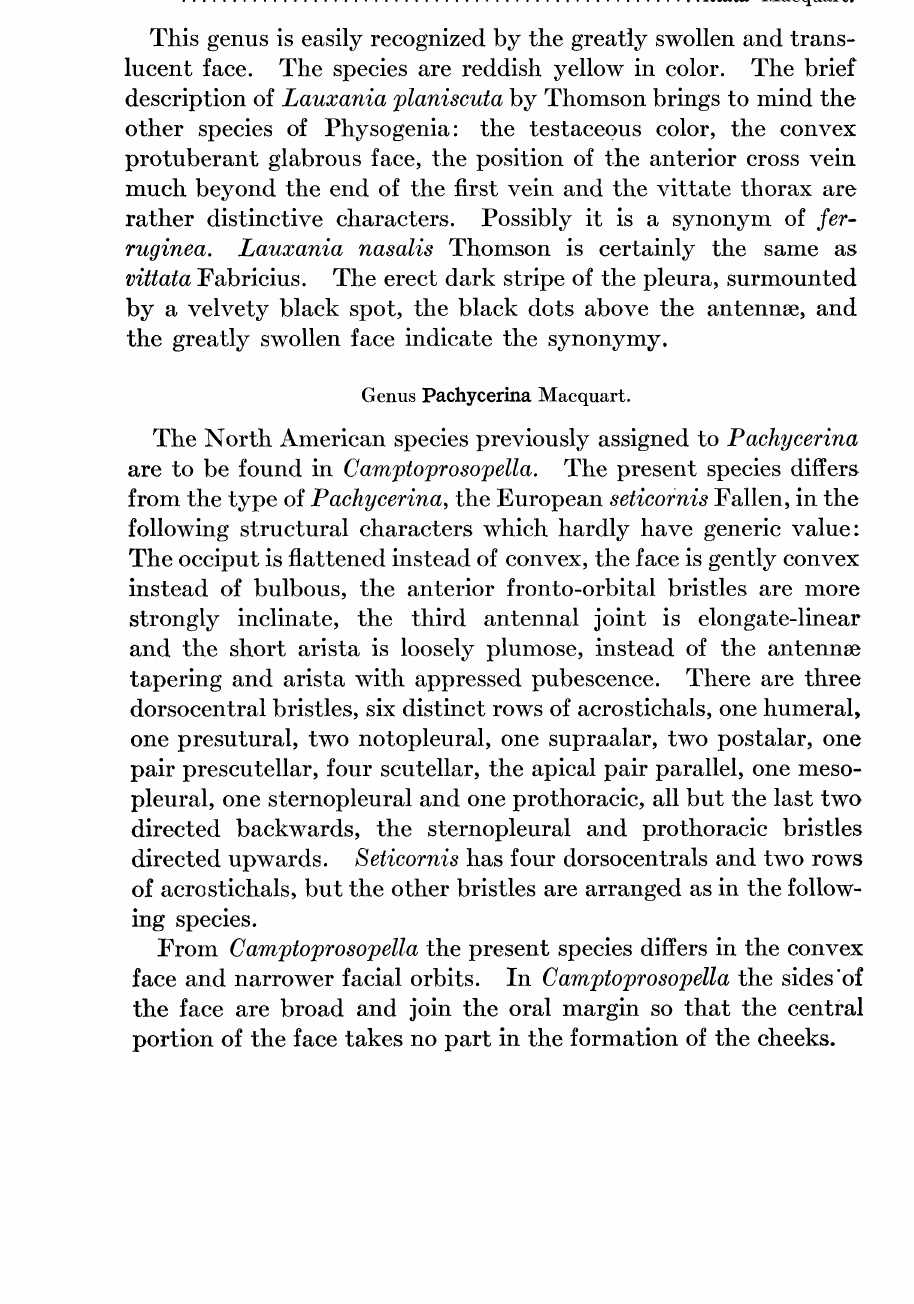
Psyche [April Face translucent yellow; thorax weakly bivittate. S. Am., Mex.* (urina Giglio-Tos) ferruginea Schiner. Face trimaculate; thorax quadrivittatc. W. Ind.*, S. Am.; Vera Cruz, Aldrich (obscuripennis Bigot, variegata Loew, nasalis Thomson) (fig. 6) vittata